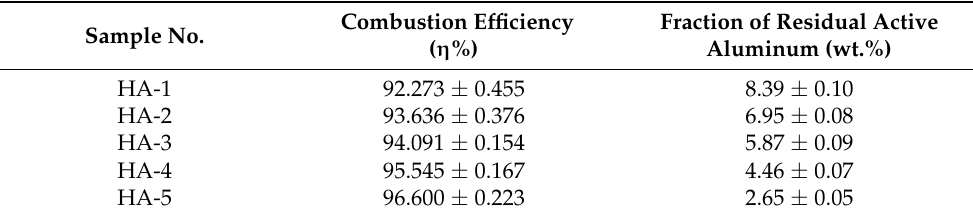
Table 4. Combustion efficiency of Al/Al–2.5Li powder and fraction of residual active aluminum of propellants.